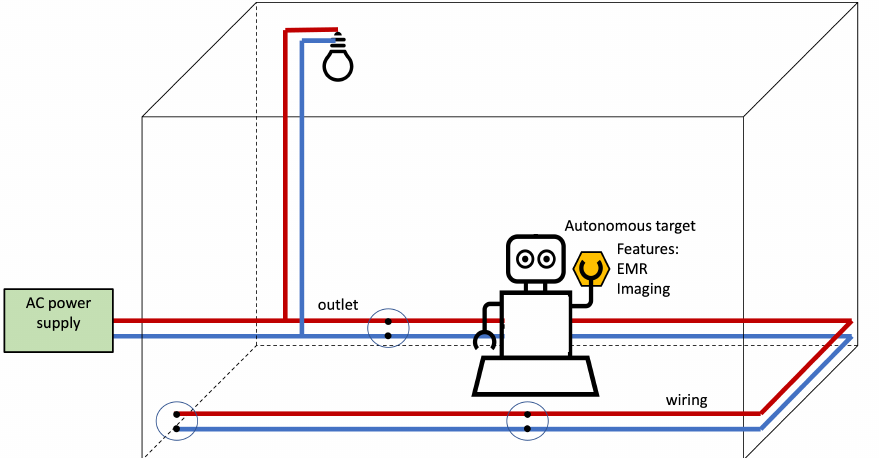
Figure 2. Infra-less Target-based PLPS architecture. The PLPS components are highlighted in